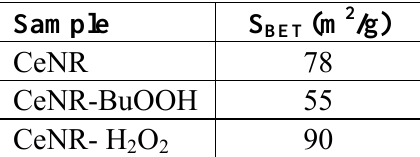
Table 1. BET specific surface